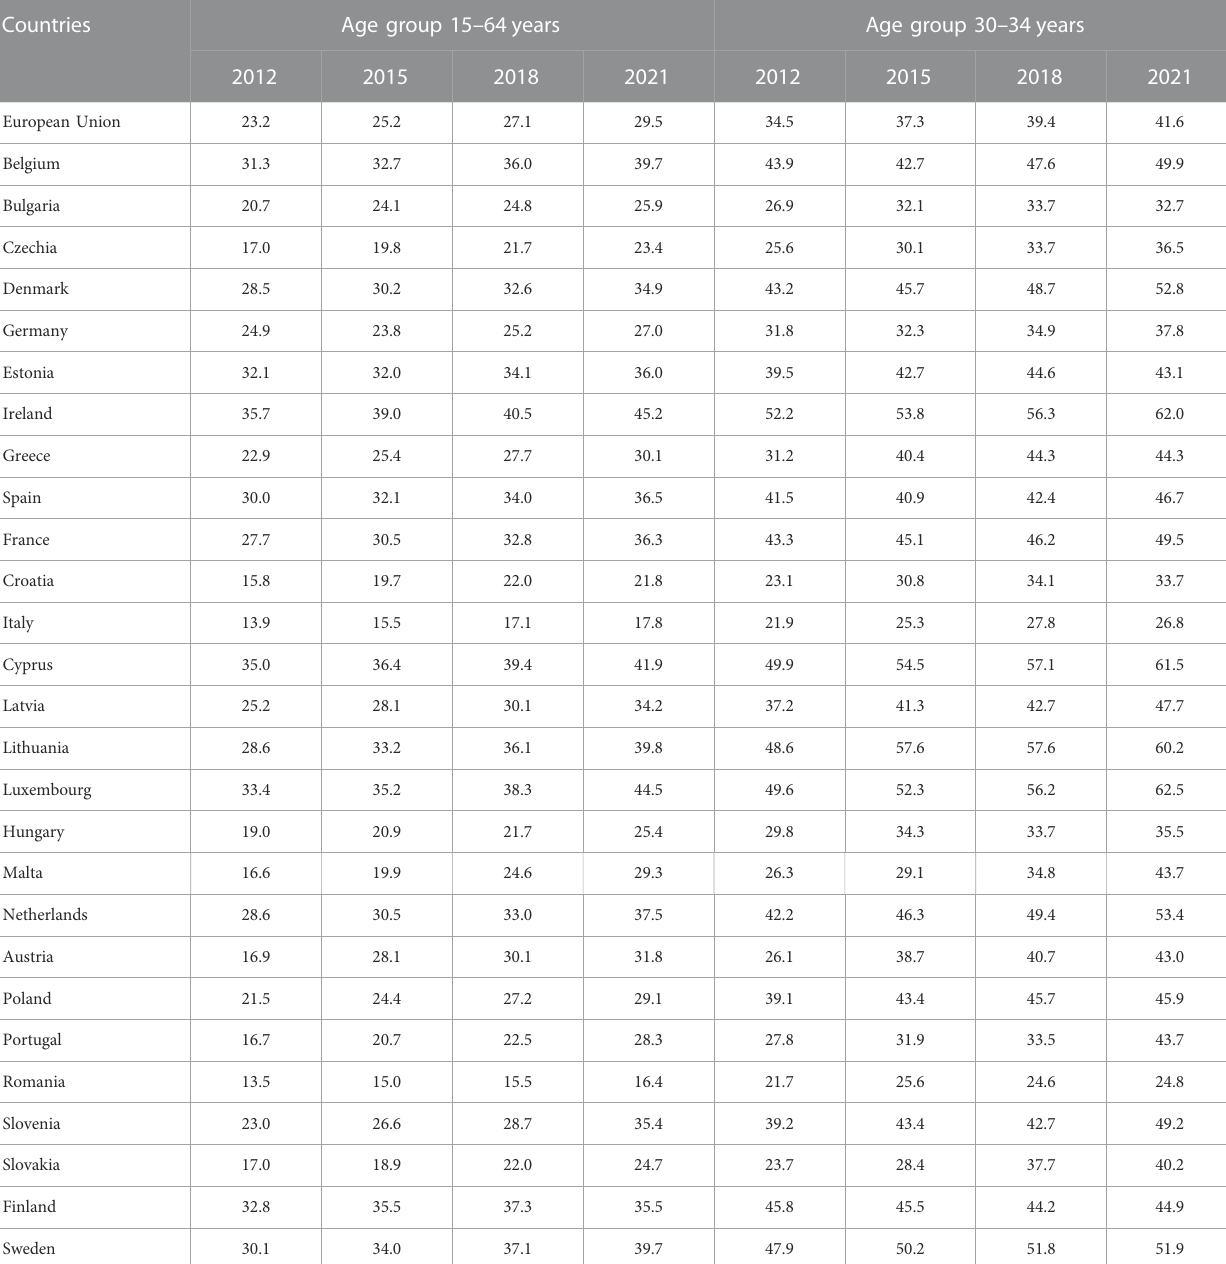
TABLE1Comparativesituation2012 – 2021oftheshareofpeopleintheagegroup15 – 64 years,respectively30 – 34 years,graduatesofthetertiaryeducationlevel (levels 5 – 8) (%).